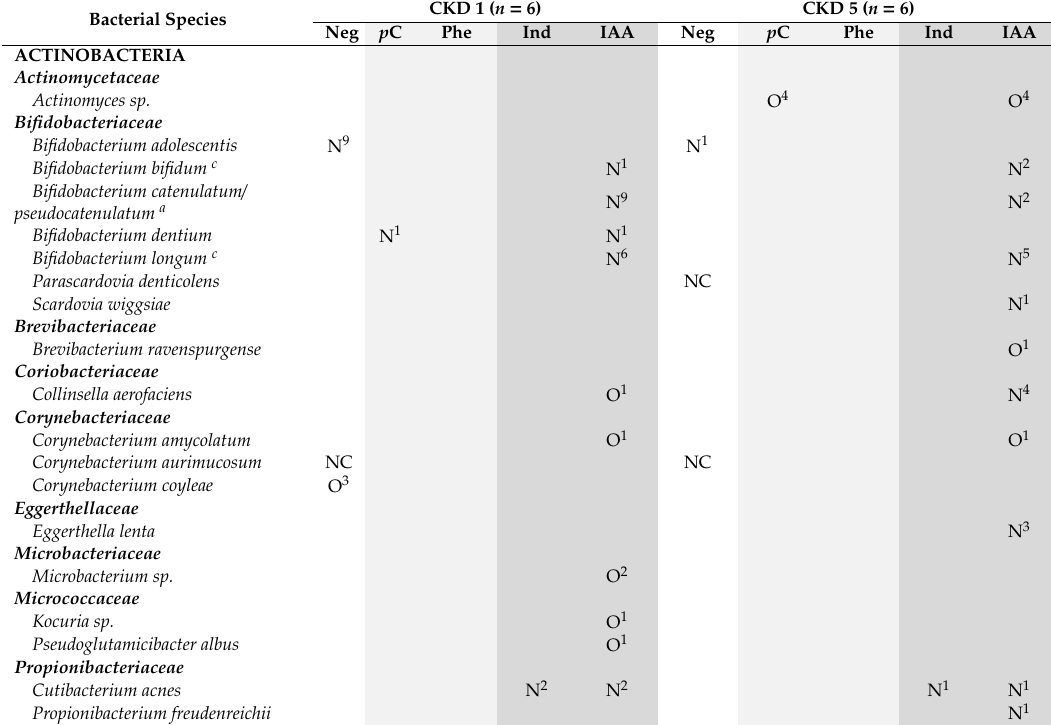
Table 1. Protein-bound uremic toxin precursor-generating capacity of bacteria isolated from fecal samples of patients with chronic kidney disease